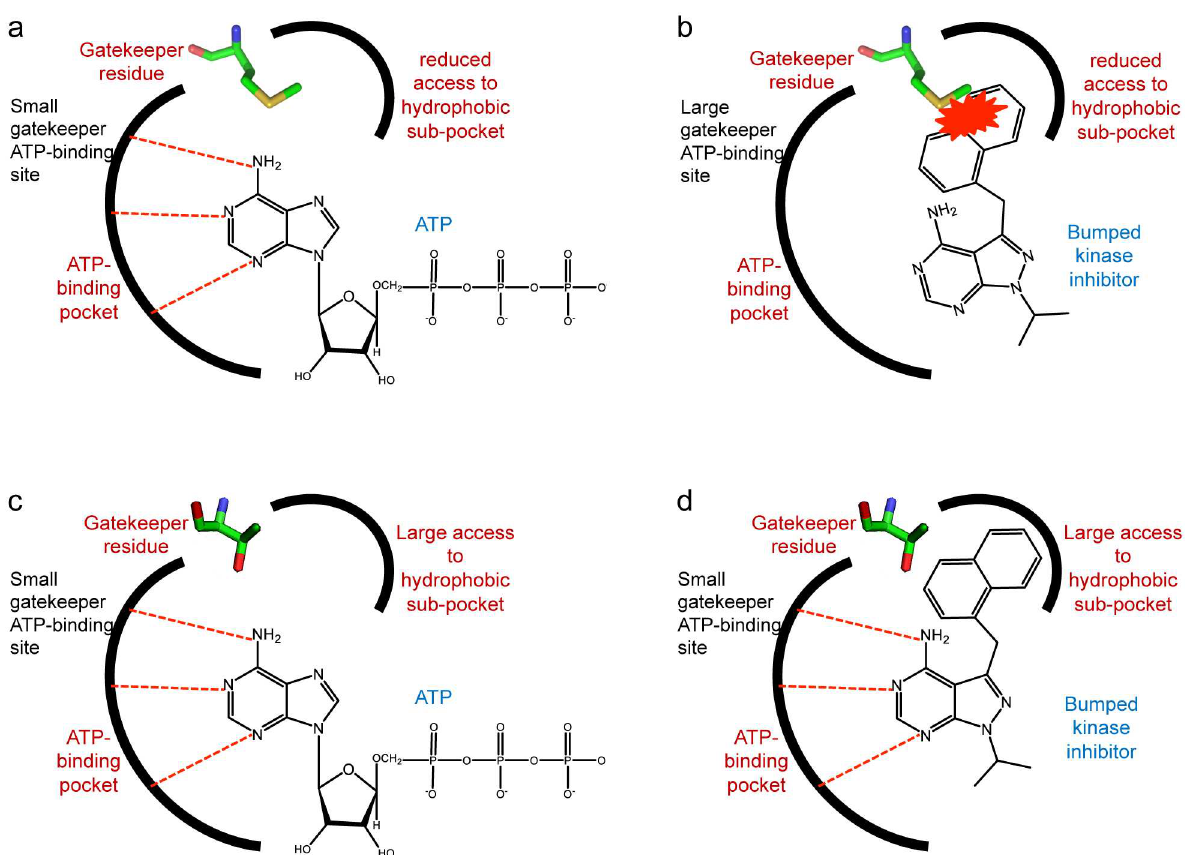
Fig 1. Structural differences between small gatekeeper ATP binding sites and large gatekeeper ATP binding sites. Structural differences form the basis for BKIs to selectivelyact on the Giardia kinases describedin this study. (a) The ATP bindingpocket of protein kinases typically contains a large amino acid gatekeeper residue (e.g. methionine). (b) BKIs do not bind to the ATP bindingsite of typical kinases because of a clash between the “bump” and the side chain of the gatekeeper. (c) A small amino acid in the gatekeeperposition has no implicationsfor ATP access to the ATP bindingsite. (d) In contrast, the small gatekeeper residue permits the BKI “bump” to extend into the hydrophobicsubpocket and outcompete